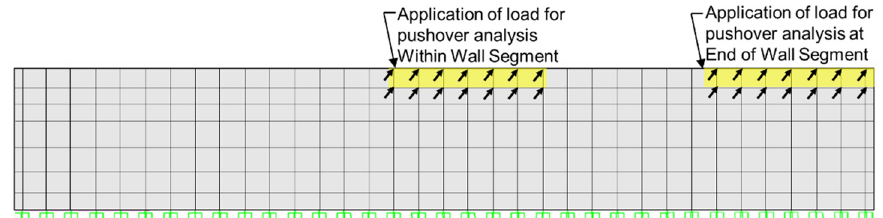
Figure 5. Loading patterns on the isolated, fixed-based parapet model.